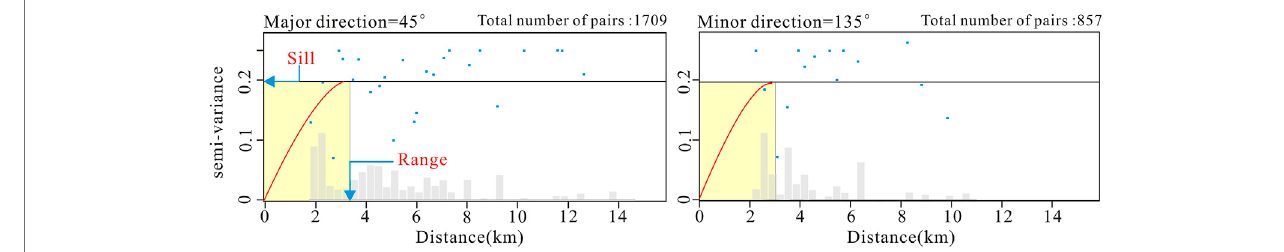
FIGURE 2 | Semi-variogram model of sand.